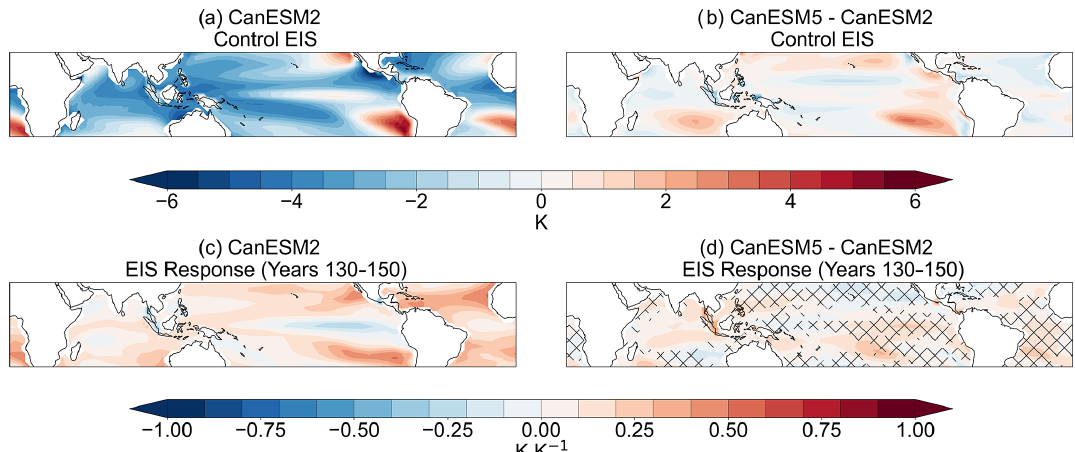
Figure 5. (a) Annual mean control climatology (150-year mean) tropical EIS for CanESM2. (b) Annual mean control climatology (150-year mean) tropical EIS for CanESM5, expressed as a difference relative to CanESM2. (c) Tropical EIS response (mean for years 130–150) for CanESM2. (d) Tropical EIS response (mean for years 130–150) for CanESM5, expressed as a difference relative to CanESM2’s response. For EIS responses, each grid box value is normalized by the global mean surface temperature response (also mean for years 130–150 relative to the control period). Hatching represents areas where the SW low-cloud feedback is more positive in CanESM5.